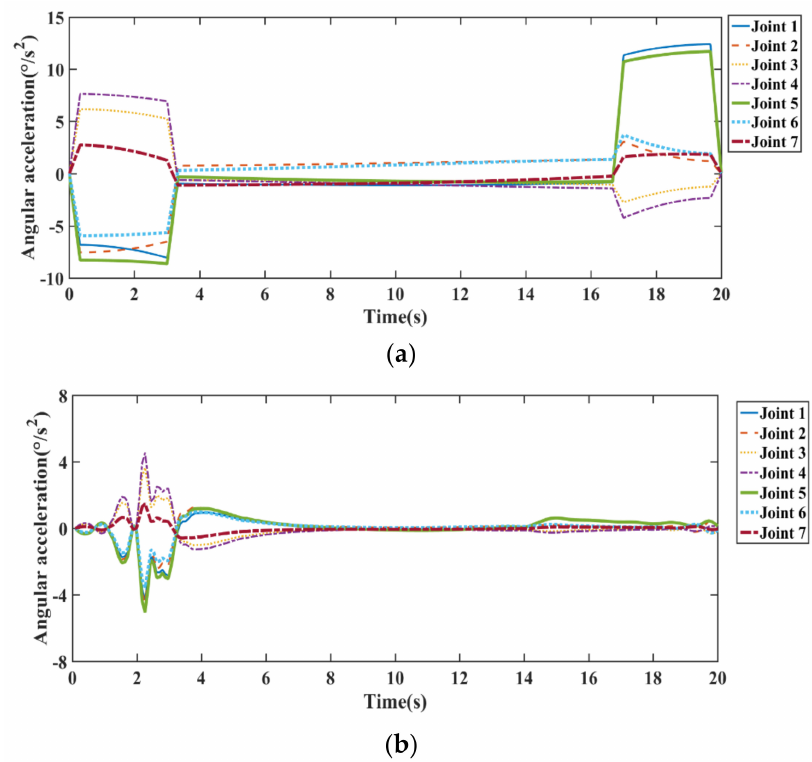
Figure 21. Joint angular acceleration of trajectories. ( a ) Without optimization, ( b ) With optimization.